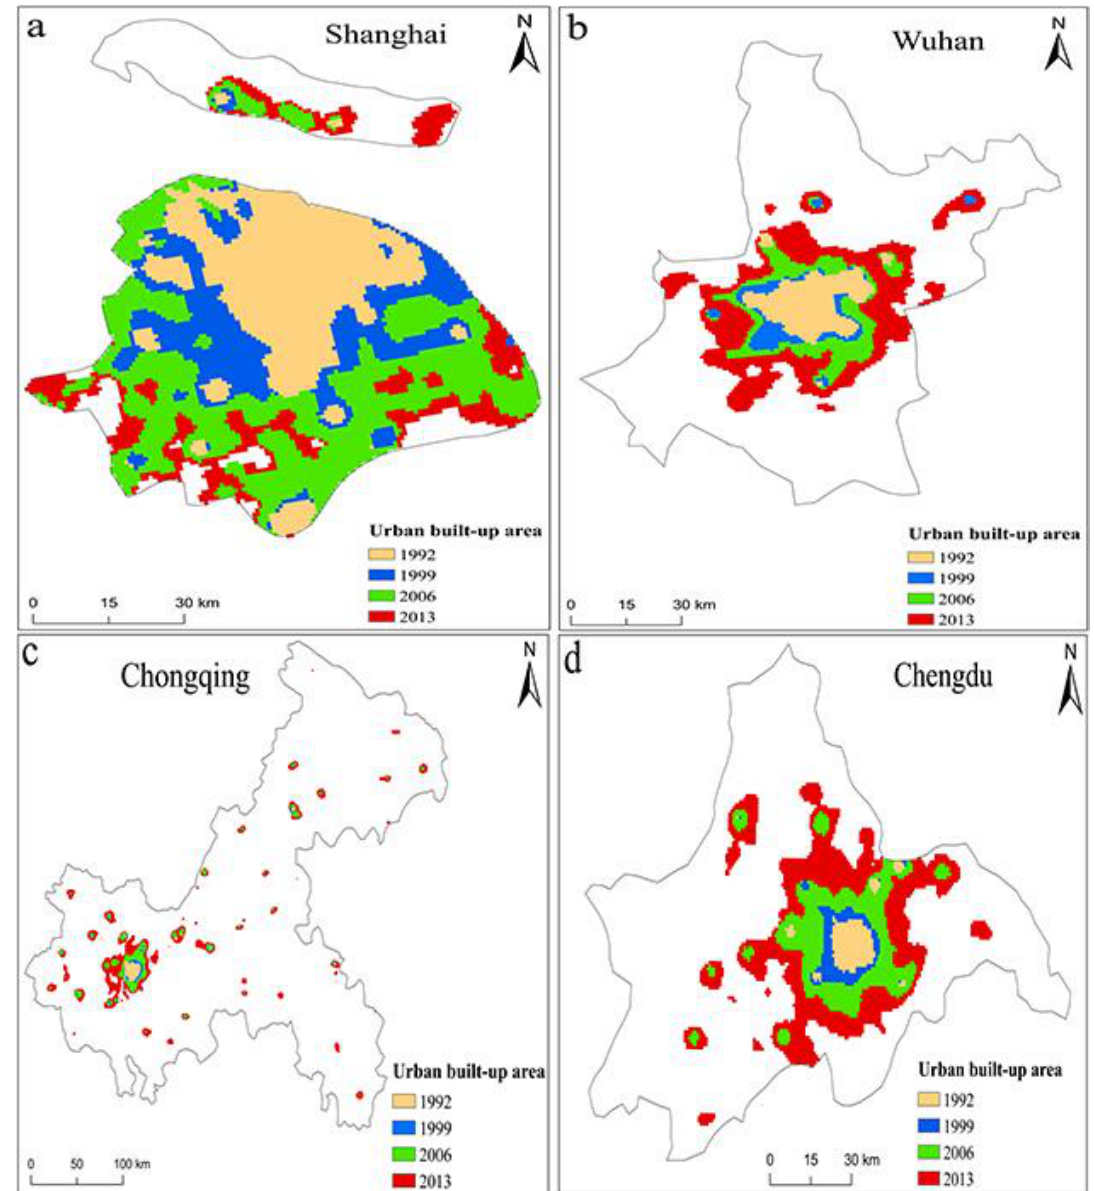
Figure 3. Evolution of urban built-up areas in the four major cities of the YREB in 1992, 1999, 2006, and 2013. ( a ) Areas of built-up areas of Shanghai in 1992, 1999, 2006 and 2013 based on night lights, ( b ) Areas of built-up areas of Wuhan in 1992, 1999, 2006 and 2013 based on night lights, ( c ) Areas of built-up areas of Chongqing in 1992, 1999, 2006 and 2013 based on night lights, ( d ) Areas of built-up areas of Chengdu in 1992, 1999, 2006 and 2013 based on night lights.